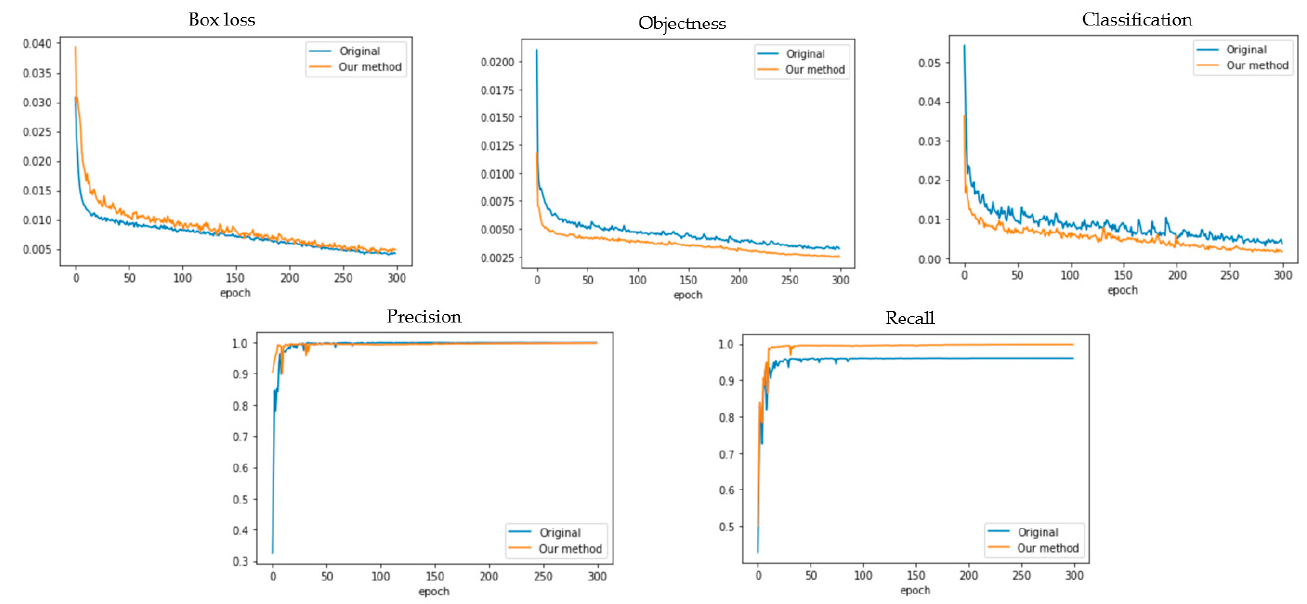
Figure 6. Training results of precious and proposed methods compared with Box loss, Objectness loss, Classification loss, Precision, and Recall.